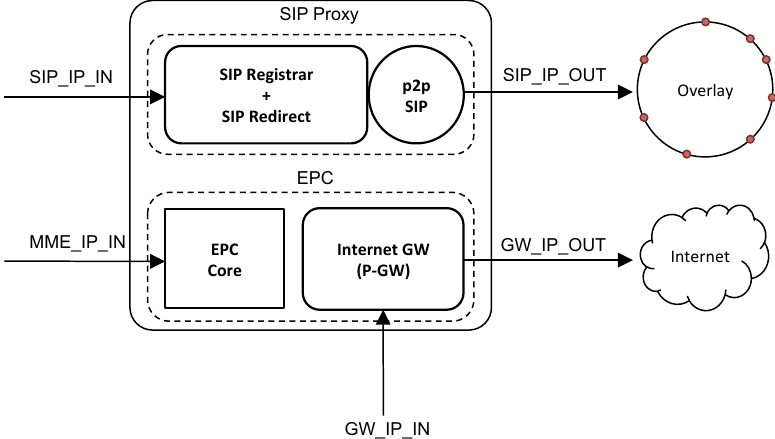
Figure 8. SN high-level architecture (SIP Proxy and EPC are